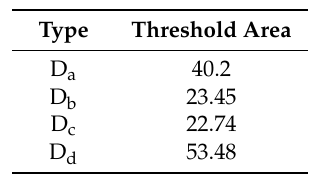
Table 3. Threshold area of four types of microactuator